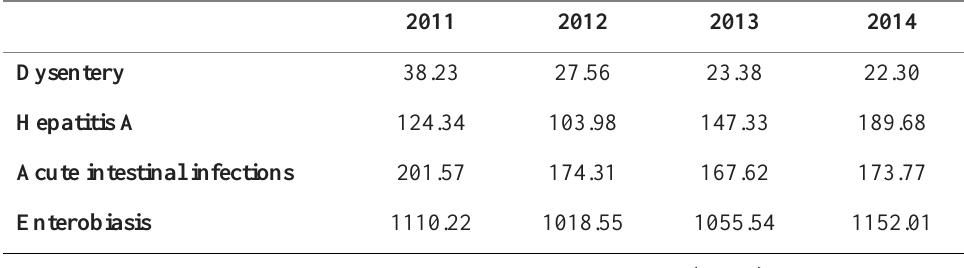
Table 1: Average incidence rates (cases per 100,000) of the four major waterborne diseases in Tashkent Province